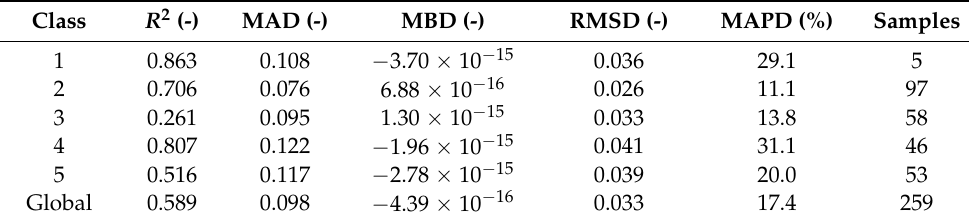
Table 6. Statistic estimators results for the reference electric energy consumption profiles.